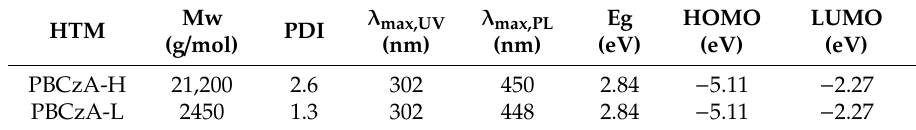
Figure 1. Schematic energy band diagram of solid-state dye-sensitized solar cells (ssDSC) with hole-transporting PCBzA. Inset shows the chemical structure of PBCzA. Table 1. Summary of molecular weight, photophysical and electrochemical properties of PBCzAs.